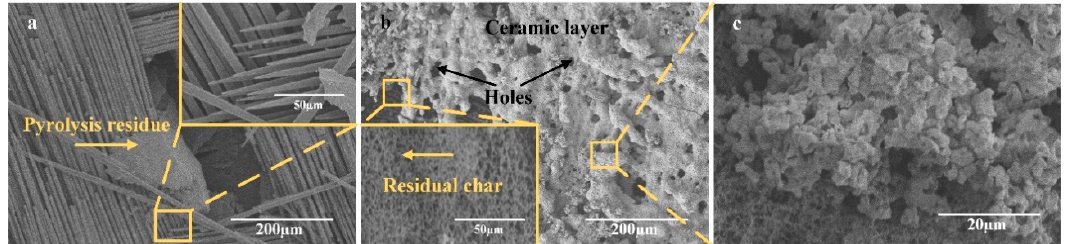
Figure 5. Micro-morphology of composites after ablation: ( a ) Unmodified composite, ( b ) 2C-C–Ph composite, and ( c ) magnification image of the ceramic layer of the 2C-C–Ph composite.